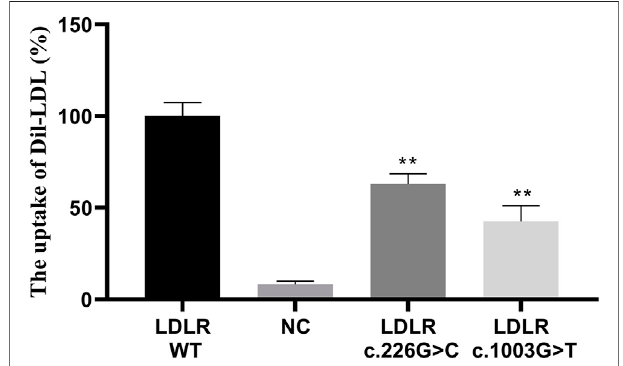
FIGURE 5 | The LDL uptake in different LDLR groups. ** indicates statistical difference between mutant group and WT group ( p <